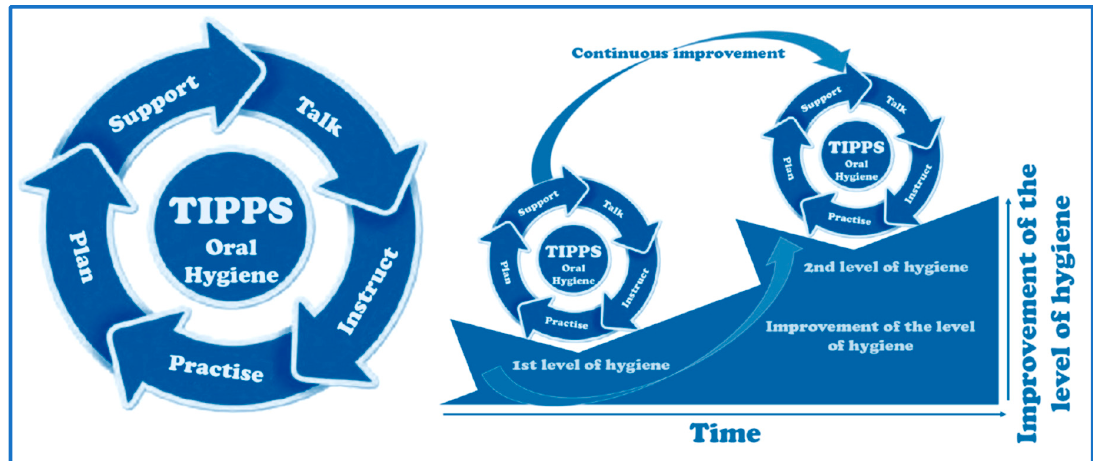
Figure 15. Diagram of Deming’s circle adopted for the prophylaxis of periodontal diseases and a diagram of the continuous improvement of the level of oral hygiene with a TIPPS circle.